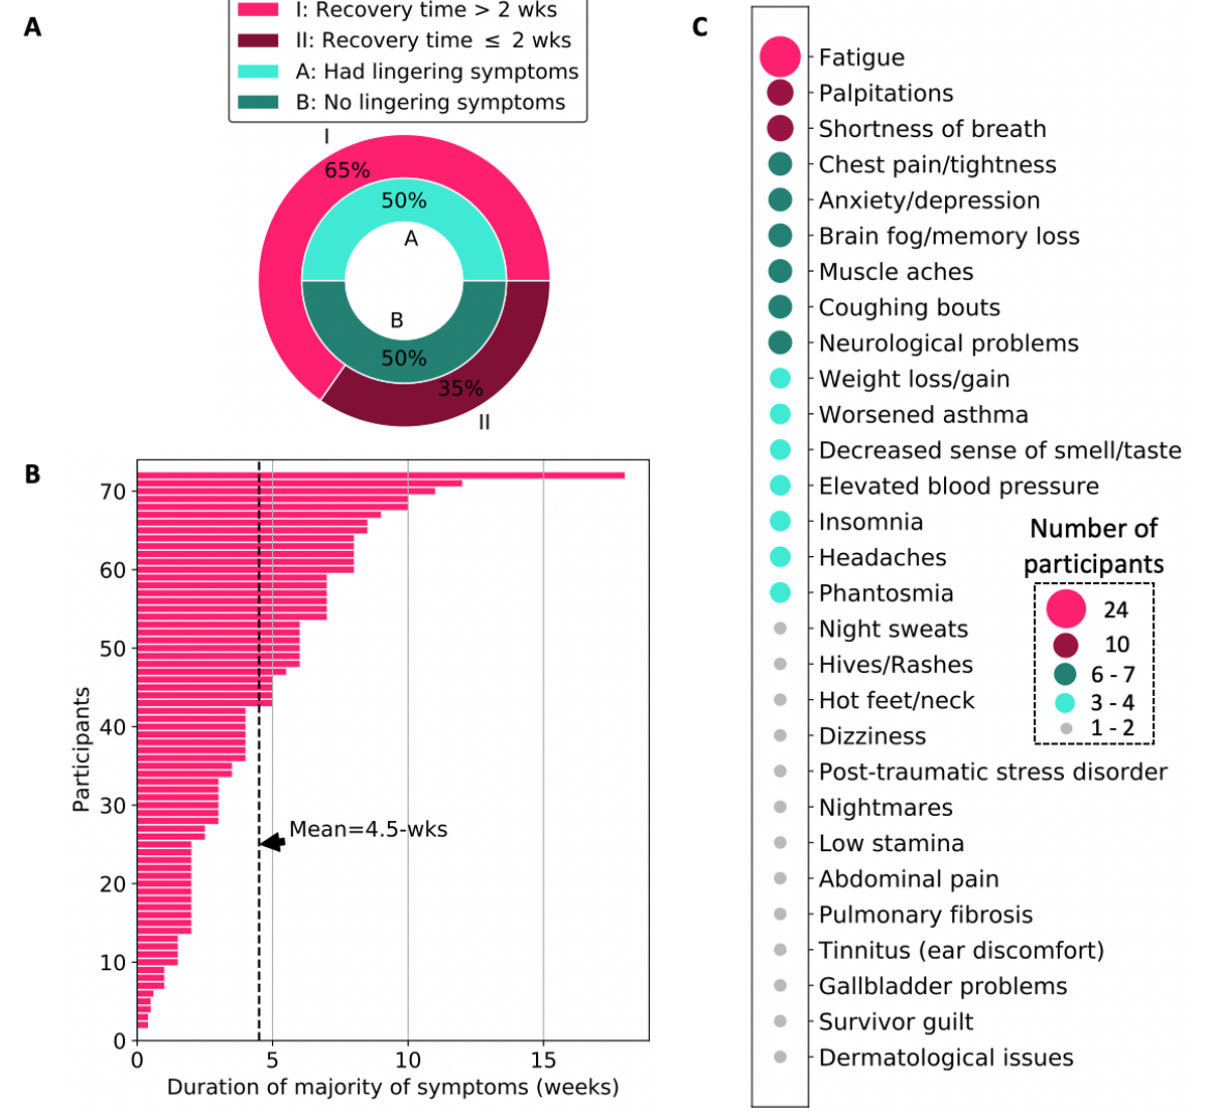
Figure 3. Overview of the road to recovery from COVID-19 for participants in this study. (A) Percentage of COVID-19 survivors who experienced lingering symptoms and a recovery time longer than the commonly cited 2-week period; (B) duration of the majority of symptoms reported (mean duration: 4.5 weeks); and (C) list and prevalence of lingering symptoms associated with